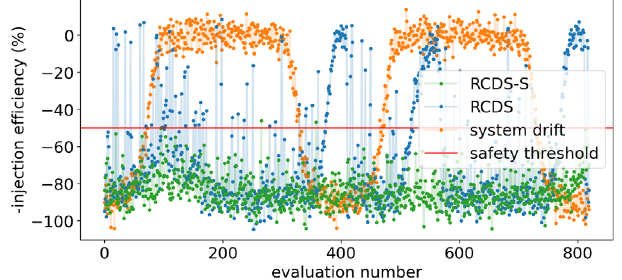
FIG. 10. RCDS-S on BTS steering optimization. The objective function is the negated injection efficiency. The orange, blue, and red curves show the cases without tuning, tuning with RCDS, or tuning with RCDS-S, respectively.